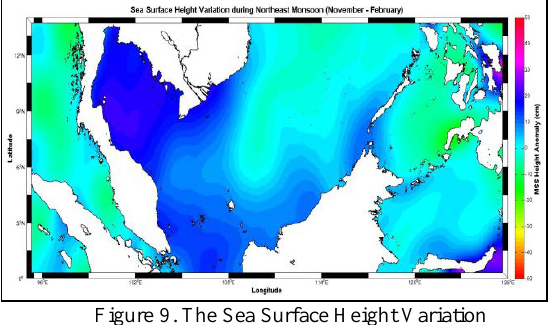
Figure 9. The Sea Surface Height Variation during Northeast